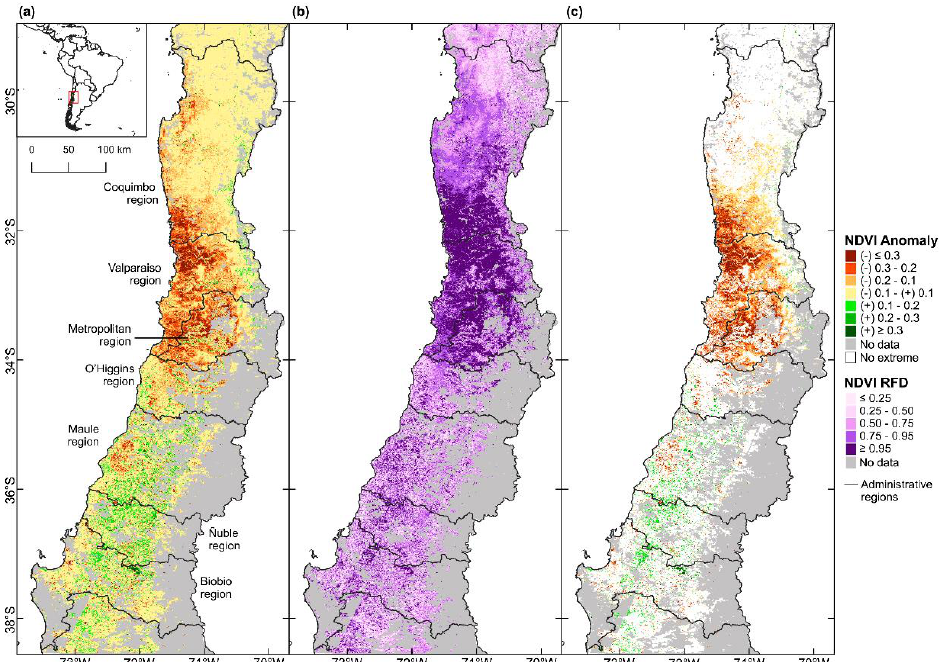
Figure 4. Extreme negative anomalies of the Normalized Difference Vegetation Index (NDVI) caused by an extreme drought in Central Chile. Calculations were performed using the ExtremeAnoMap function of the “npphen” R-package and MOD13Q1 data from the Terra satellite and considered 239 NDVI scenes of the 2000–2009 period as a reference. The maps correspond to 30 September 2019 and show ( a ) NDVI anomalies, ( b ) the position of the NDVI observations within the reference frequency distribution (RFD), and ( c ) NDVI anomalies at RFD >= 0.95. The “extreme” NDVI anomalies shown in panel ( c ), defined by RFD >= 0.95, are NDVI records falling among the 2.5% range of the lowest NDVI values of the reference period.